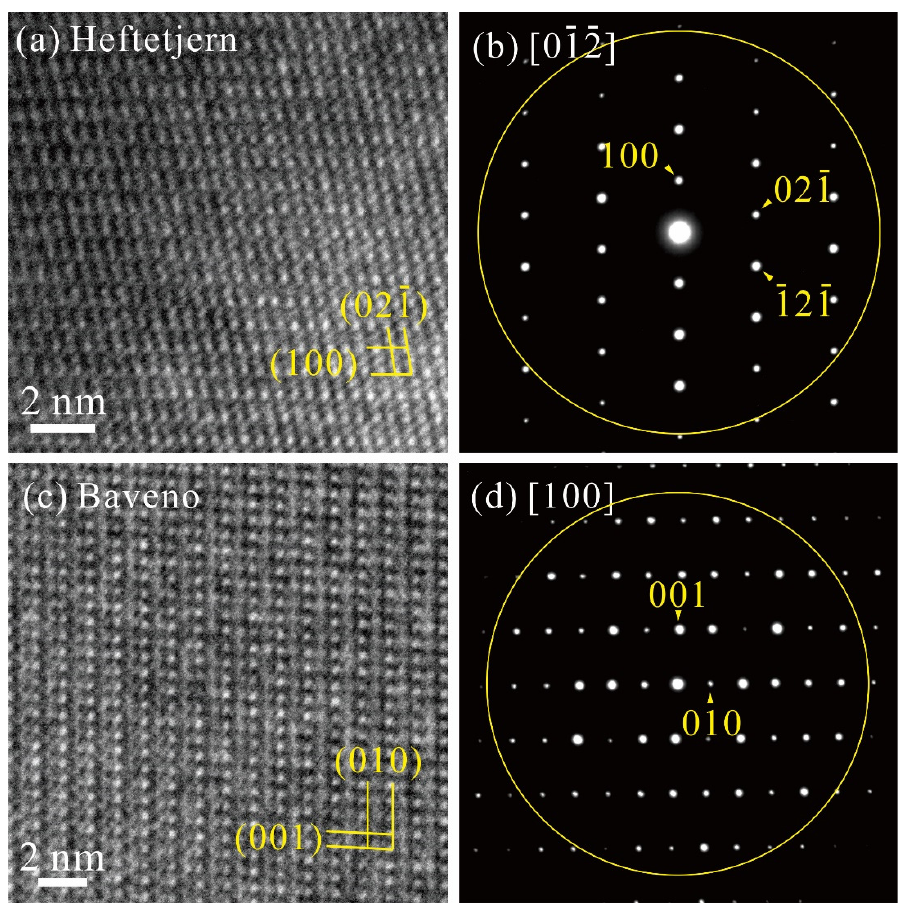
Figure 2. Transmission electron microscopic (TEM) images of Sc-rich babingtonite for Heftetjern ( a , b ) and Baveno ( c , d ) specimens. HRTEM images ( a , c ) and SAED pattern ( b , d ) are presented for each specimen. The rings (d ≈ 1.9 Å) in SAED patterns show the objective lens aperture used for HRTEM.